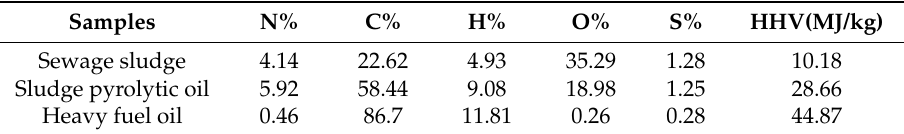
Table 6. Elemental analysis and heating values of different